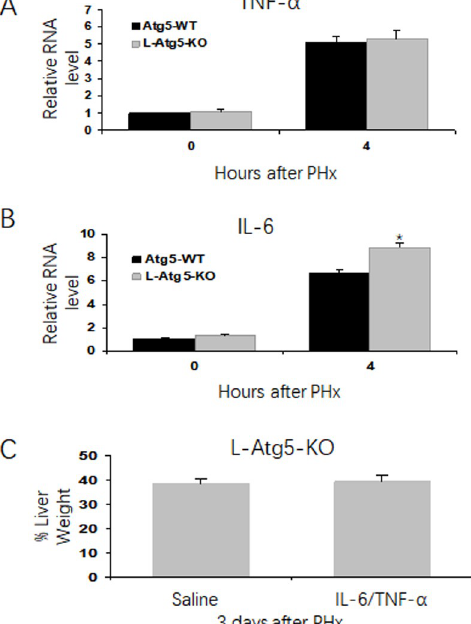
Fig 2. Impaired hepatic liver proliferation is not associated with cytokines response in the regenerating liver in control and L-Atg5 KO mice. Analysis of IL-6 (A) and TNF- α (B) mRNA levels in the mouse liver tissue by real-time RT-PCR. The RNA level of wild-type mice was arbitrarily defined as one. (C) L-Atg5-KO mice were injected with IL-6 and TNF- α (500 μ g/kg), or saline at two hours before PHx and one day after PHx. The mice were sacrificed at 3 days after PHx, and the liver regeneration rate was measured (Three mice for each group). The average liver weight prior to PHx was defined as 100%. � , p < 0.05, Data were analyzed by the Student’s t -test.